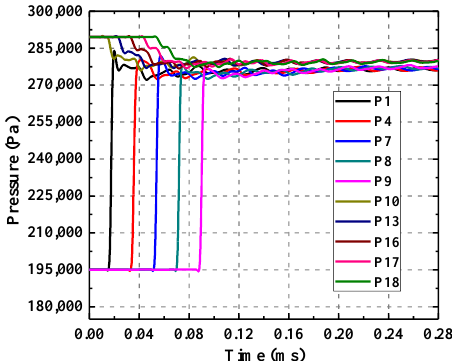
Figure 20. Pressure-time curves of the monitor points parallel with the passage walls.